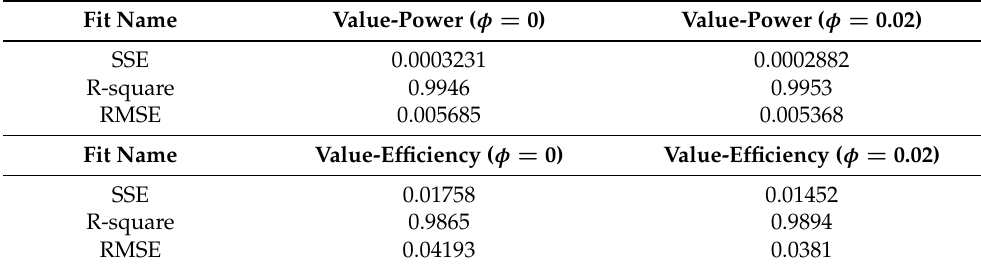
Table 5. Goodness of the fit for the polynomial